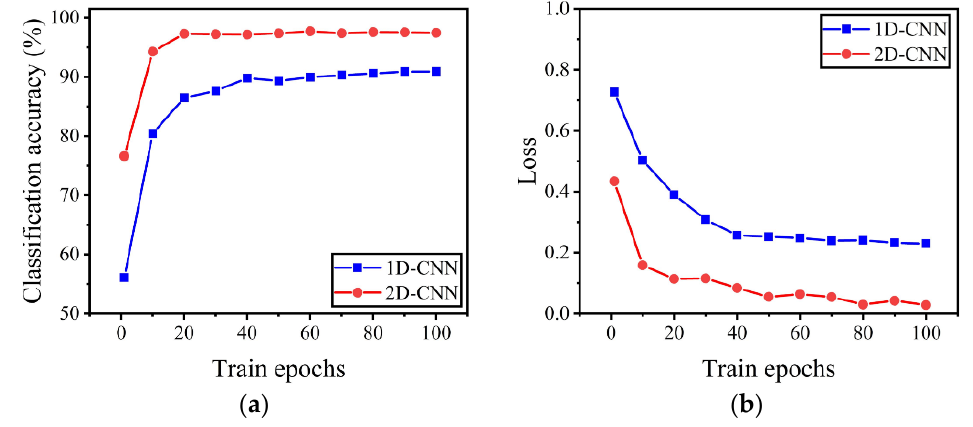
Figure 9. The iterative process of training sets. ( a ) Classification accuracy; ( b ) Loss.